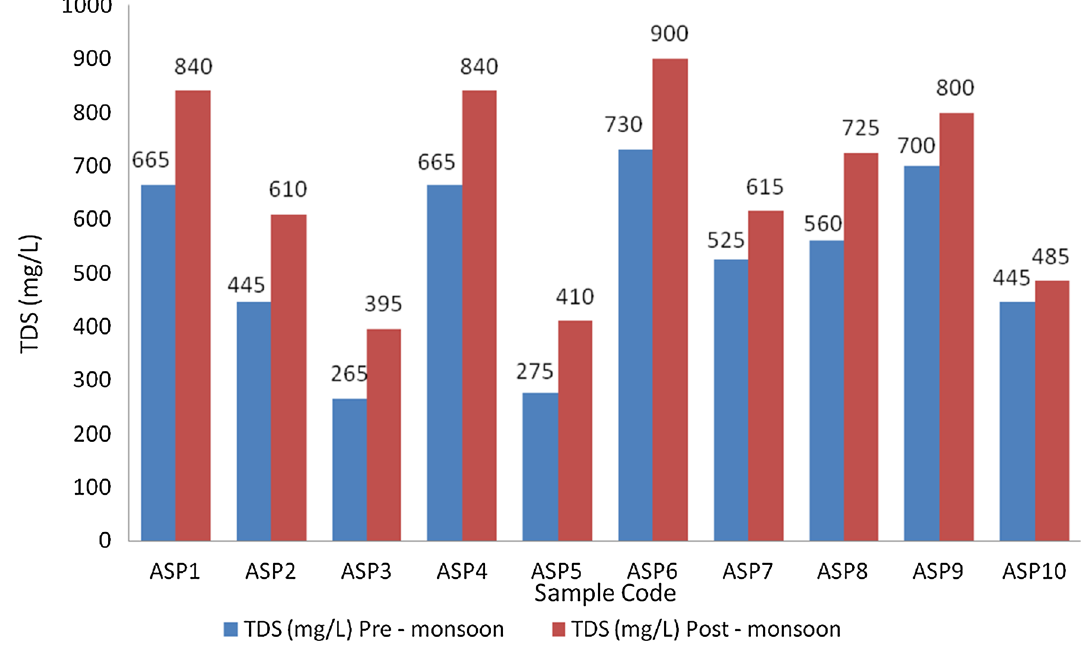
Fig. 13 TDS in samples BIS limit (2000 mg/L) collected from Laxmi